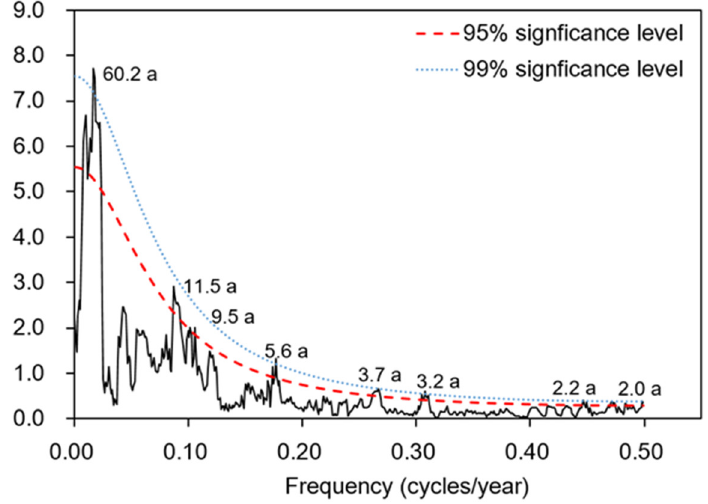
Figure 7. MTM spectral density of the runoff reconstruction of the Kaiken River. The dash and dotted lines indicate the 0.05 and 0.01 confidence level, respectively.